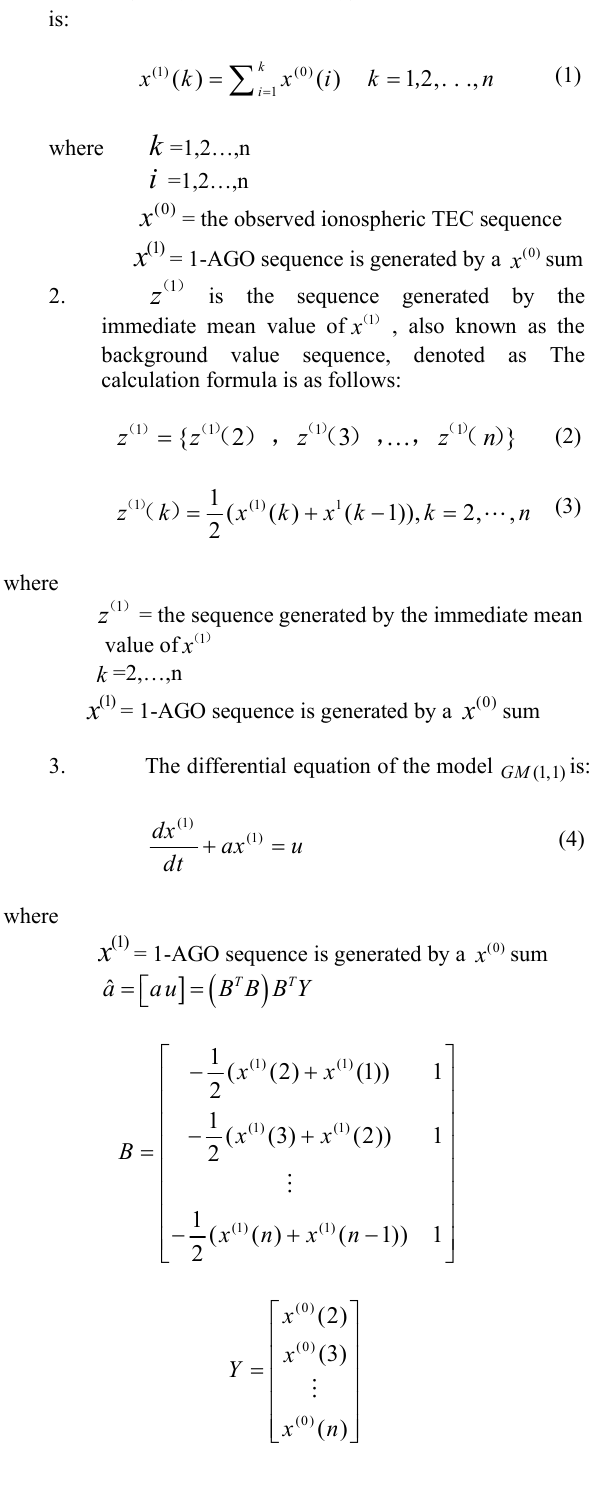
reduction value of the model is: